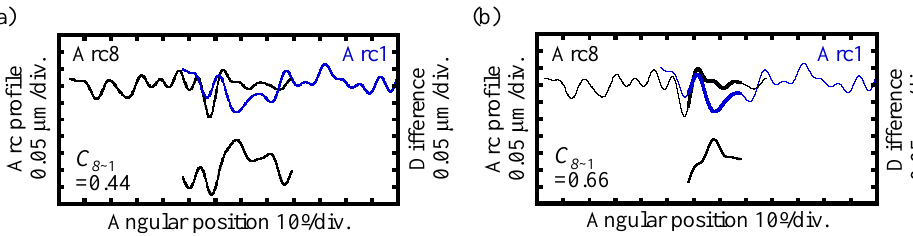
Figure 12. The relationship between Arc8 and Arc1 after the stitching operations: ( a ) Stitching by employing all data in the overlapped region; ( b ) Stitching by employing the profile data in the overlapped region except the edge region in an arc to be stitched.